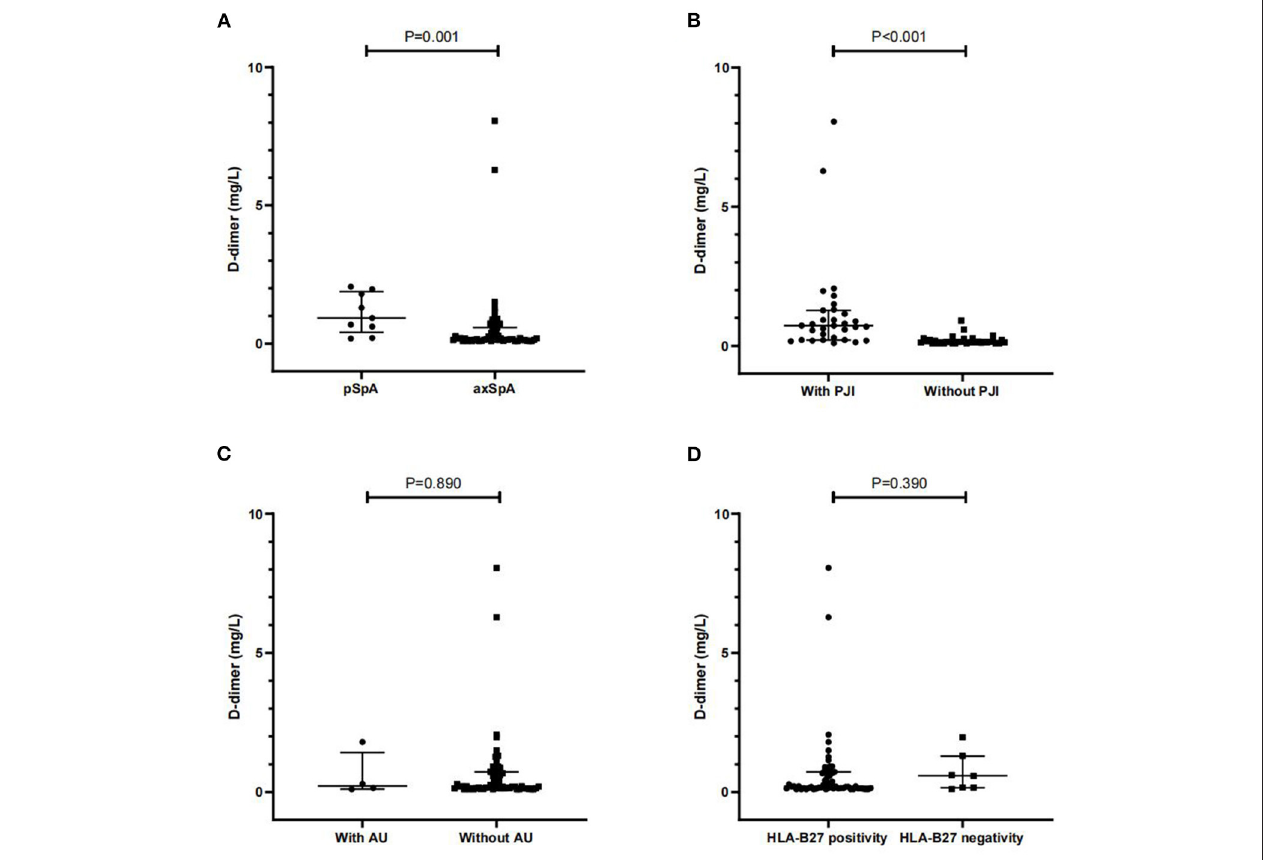
FIGURE 2 | Comparisons of D-dimer between axial spondyloarthritis (axSpA) and pSpA patients (A) , and between SpA patients with and without PJI (B) , AU (C) and HLA-B27 positivity (D) . PJI peripheral joint involvement; AU anterior uveitis; HLA-B27 human leukocyte antigen B27. Data are expressed as median and interquartile range